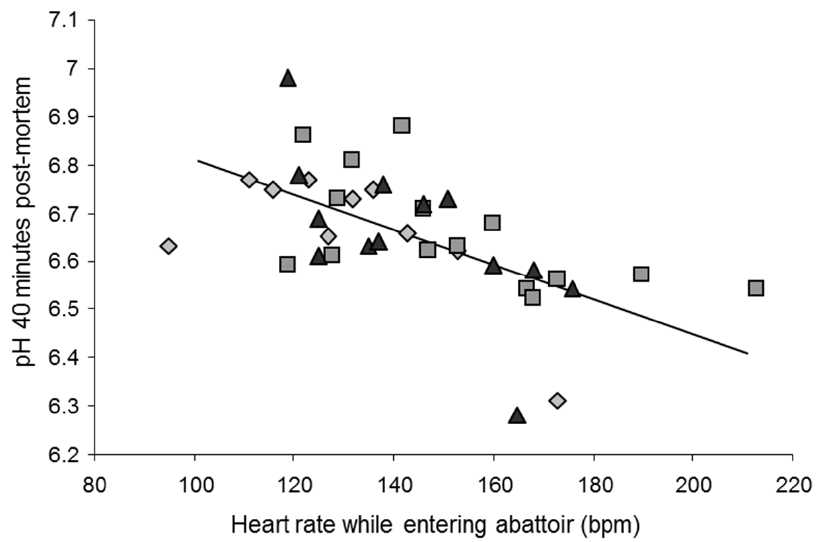
Figure 2. Faster heart rates are associated with faster early postmortem pH decline of the Semitendinosis muscle, explaining 34% of the variability between the individuals ( r = 0.58; p = 0.0001). Rhombuses, squares and triangles represent Angus, Blond d’Aquitaine and Limousin young bulls, respectively. Reproduced from [38], with permission from Elsevier.